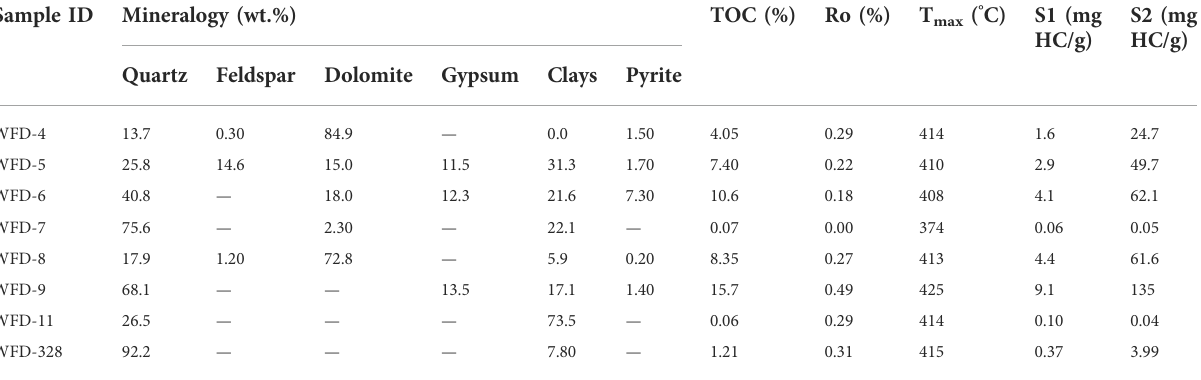
TABLE 1 Mineralogical, petrophysical, and geochemical properties from XRD, and rock pyrolysis results (HC: hydrocarbons; wt.%: weight percentage). Sample